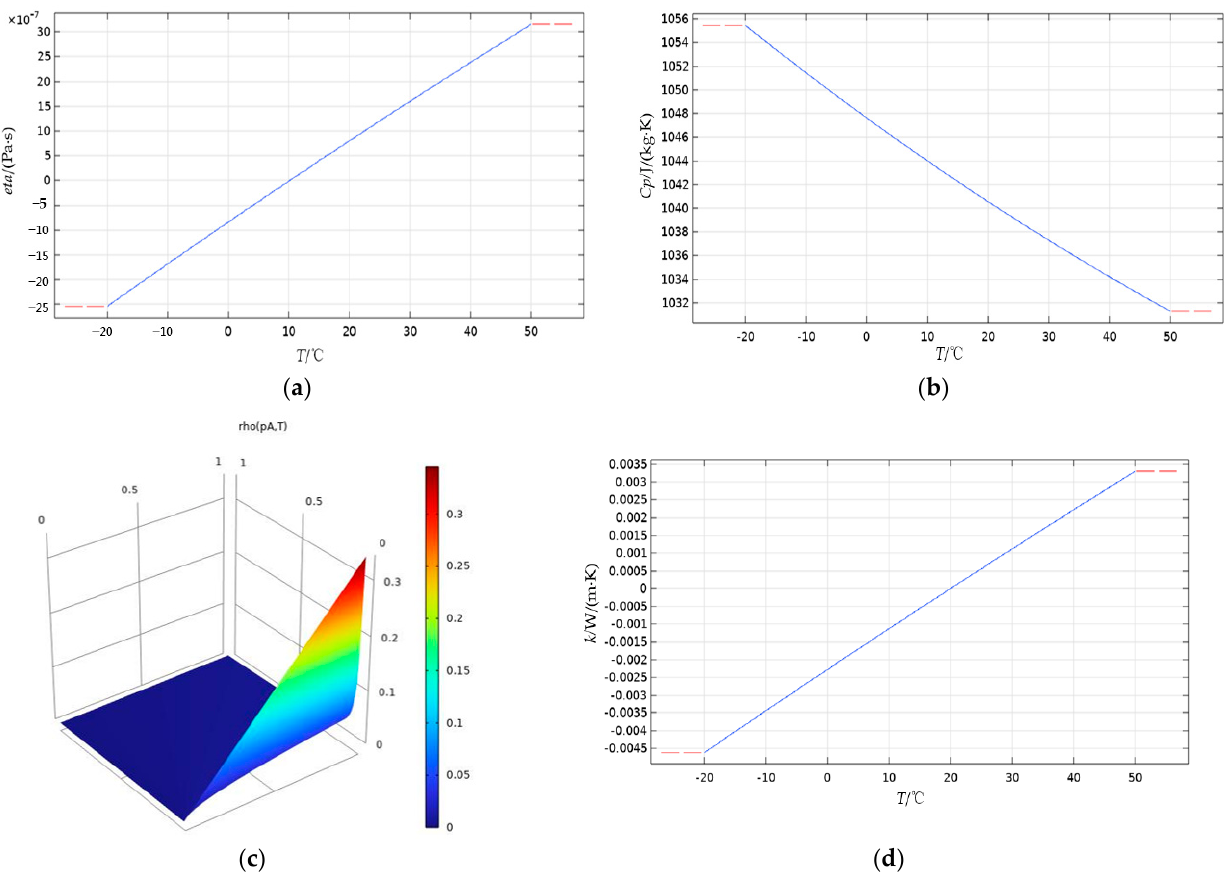
Figure 9. Ambient domain parameters: ( a ) kinetic viscosity; ( b ) constant pressure heat capacity; ( c ) density; ( d ) thermal conductivity of air.